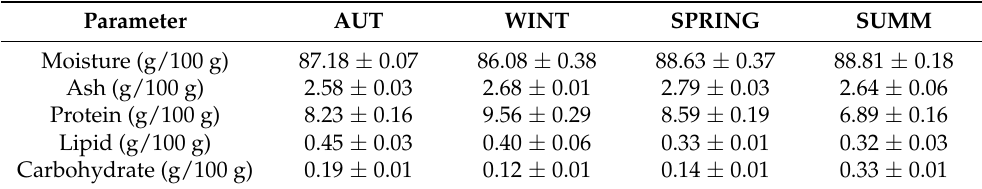
Table 1. Seasonal changes in proximate composition of A. opercularis during the study period. Values are mean ± S.D. ( n =